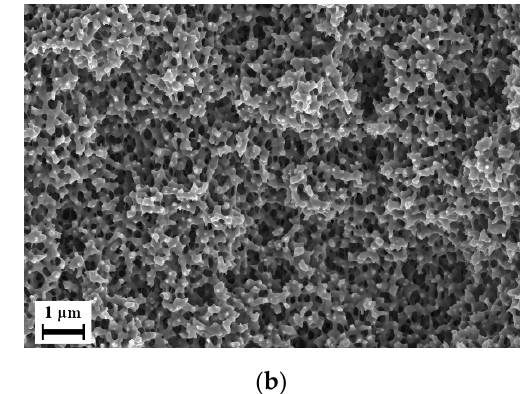
Figure 14. Scanning electron micrographs of sandwich-type sample manufactured using method II with blend H-32 after batch foaming before post-treatment: ( a ) at 200× magnification; ( b ) at 10,000× magnification on layer with Blend H-32.